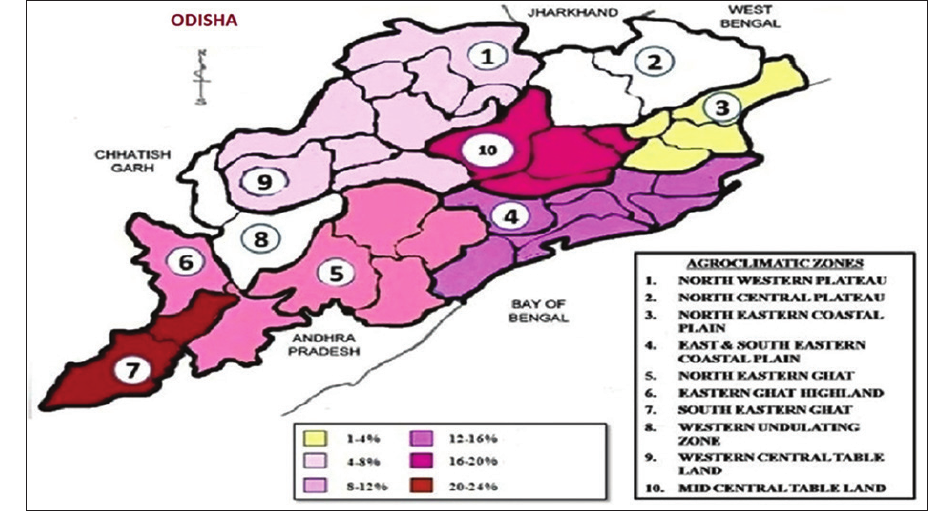
Figure-2: Variation in seroprevalence of sheep pox among different agro-climatic